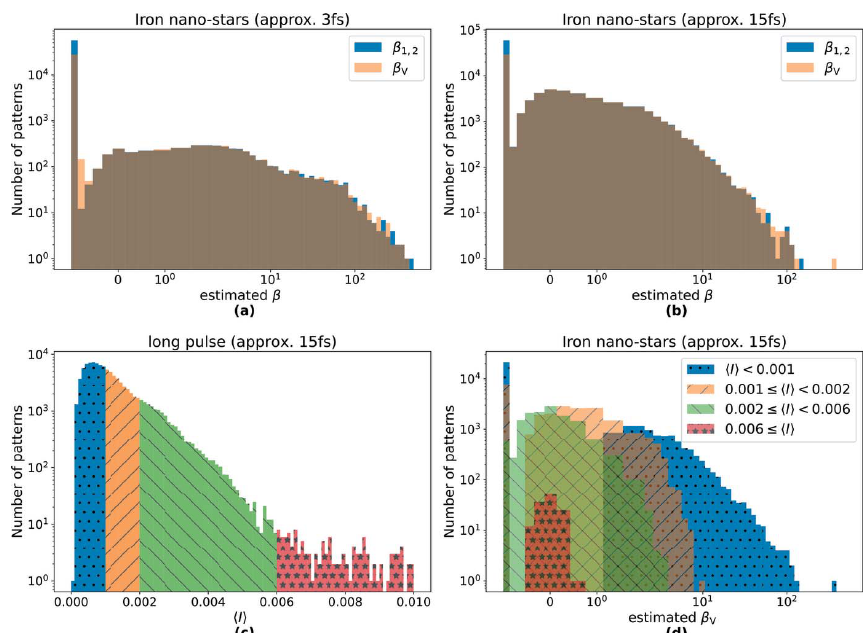
Figure 2 Histograms of single pattern speckle contrast estimates (cid:6) 1,2 and (cid:6) V , obtained from measured X-ray fluorescence photons. ( a ) Iron nano-stars, measured with 3 fs pulses, with the sample variance Var( (cid:6) 1,2 ) = 708 and Var( (cid:6) V ) = 6253. ( b ) Iron nano-stars, measured with 15 fs pulses, with Var( (cid:6) 1,2 ) = 11 and Var( (cid:6) V ) = 485. Note the long-tailed distribution with many entries at (cid:2) 1 and some quite high (cid:6) estimates, along with the high sample variance. ( c ) Histogram of mean photon counts [equivalent to Fig. 1( d )], divided into four parts as indicated by four colors. ( d ) Histograms of speckle contrast estimates for different regions of mean photon counts. Note the transition from a long-tailed distribution with large peak at (cid:6) = (cid:2) 1 at low h I i (blue) to a more Gaussian-like distribution for higher h I i